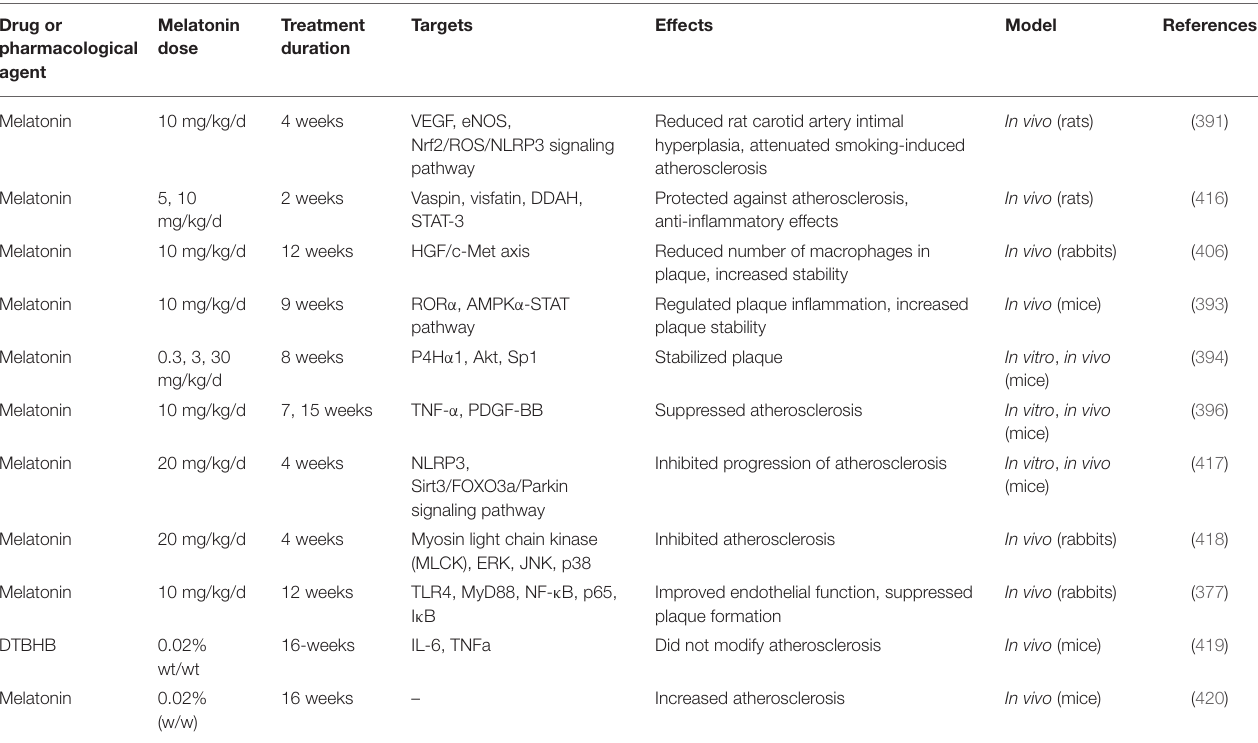
TABLE 5 | The effects of melatonin on atherosclerosis and intimal hyperplasia. Drug or